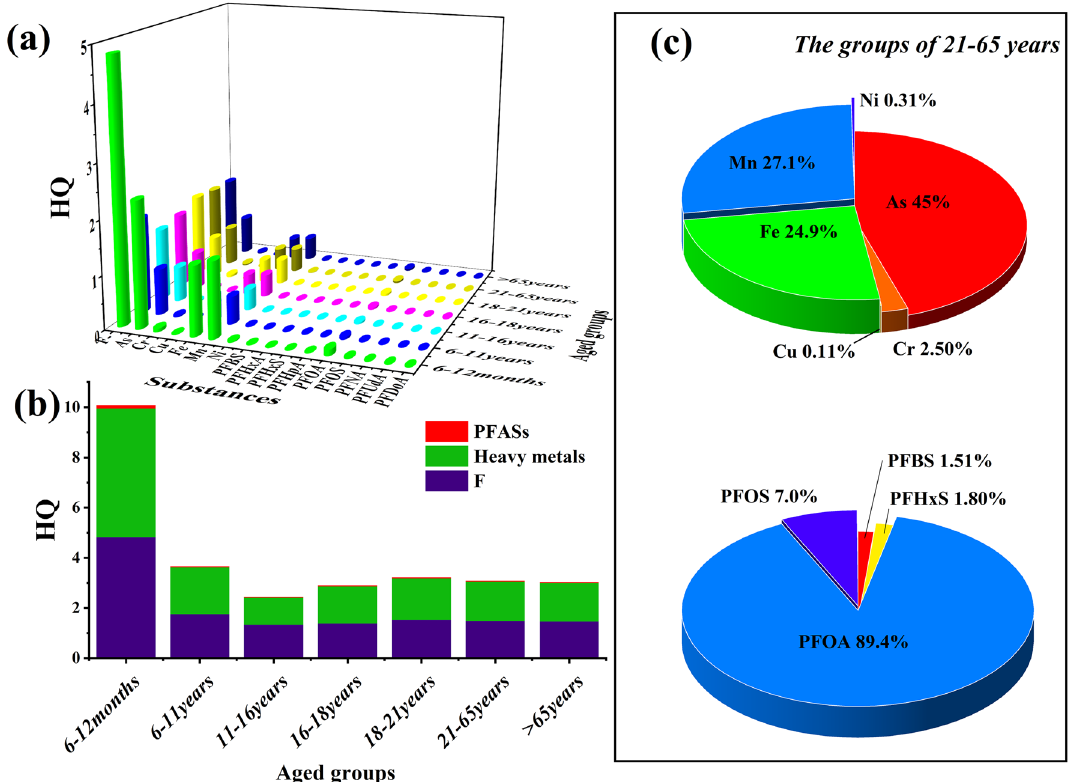
Figure 3. Health risk assessment for heavy metals, F − and PFASs in groundwater from the FCP of Fuxin City, Liaoning Province; ( a ) HQ value for different age groups; ( b ) HQ mix value for different age groups and ( c ) HQ contributions from different heavy metals and individual PFASs for subjects aged 21–65 year